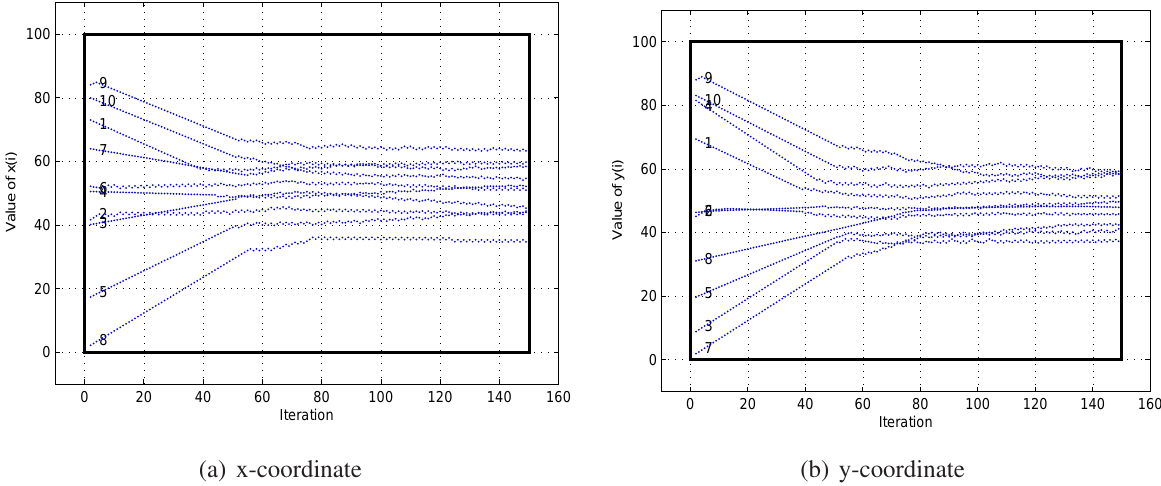
Figure 2 . oscillating characteristic of coordinates of mobile sensor nodes under